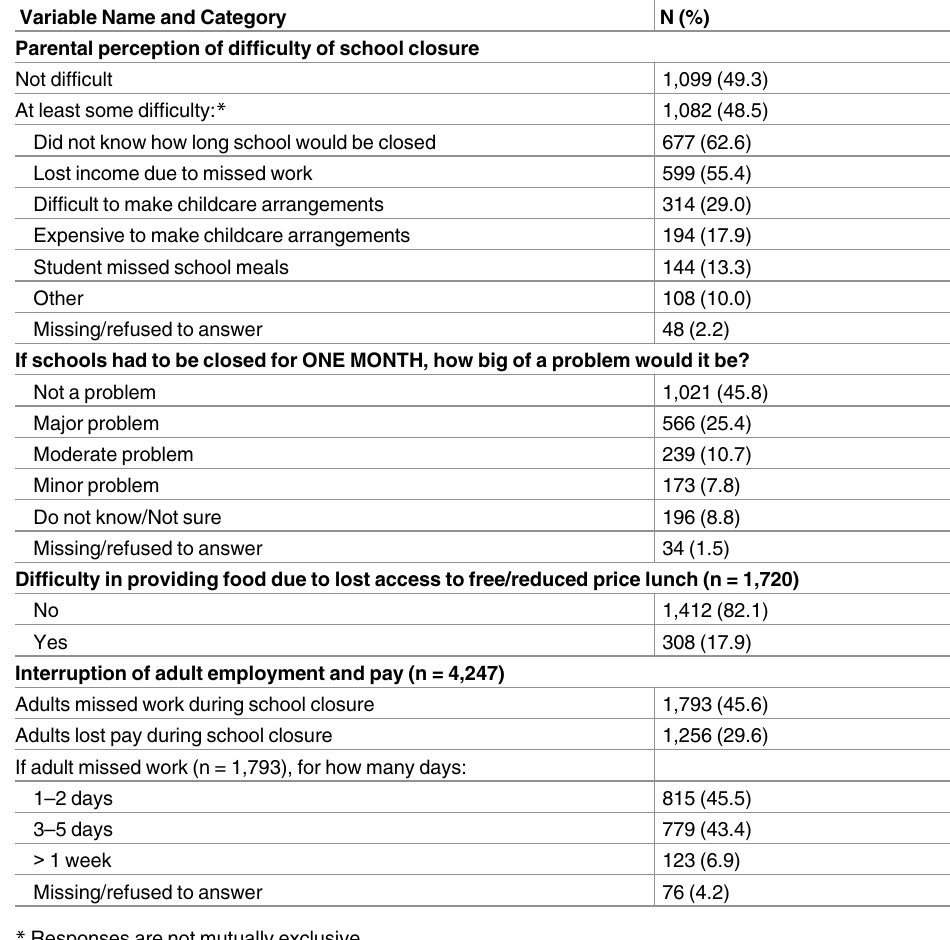
Table 2. Reported difficulties and employment and income interruptions related to unplanned school closure, Harrison County School District, Mississippi, August 2012 (N =